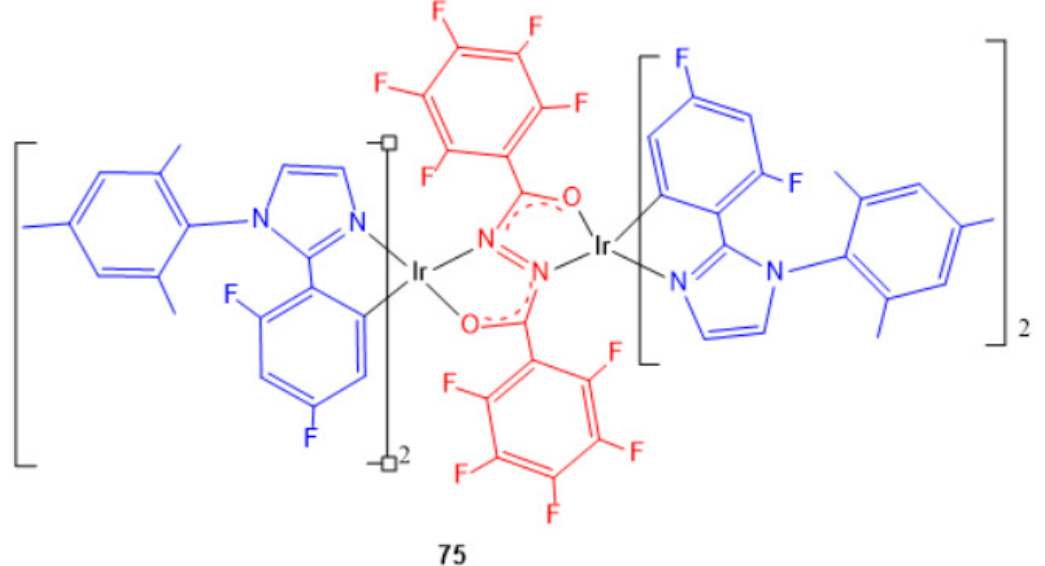
Figure 9. Chemical and crystal structure of diiridium cyclometalated complex with functionalized formyl group [92]. [(Wong et al.). Copyright reproduced with permission from Royal Society of Chemistry (2015)].